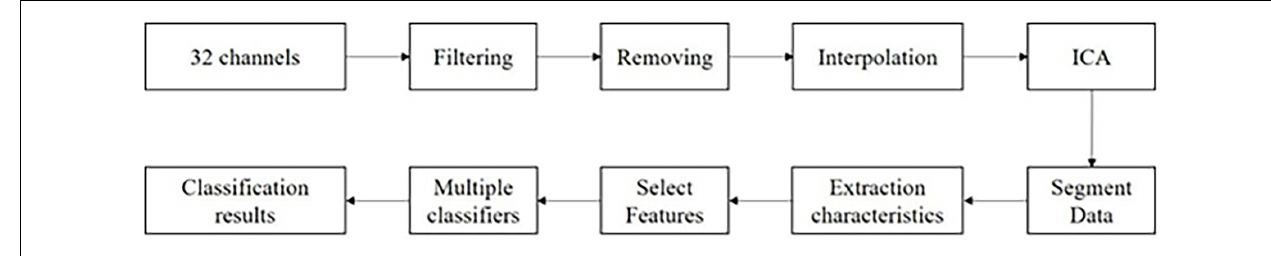
FIGURE 1 | Flow chart of multi-channel emotion classification algorithm.